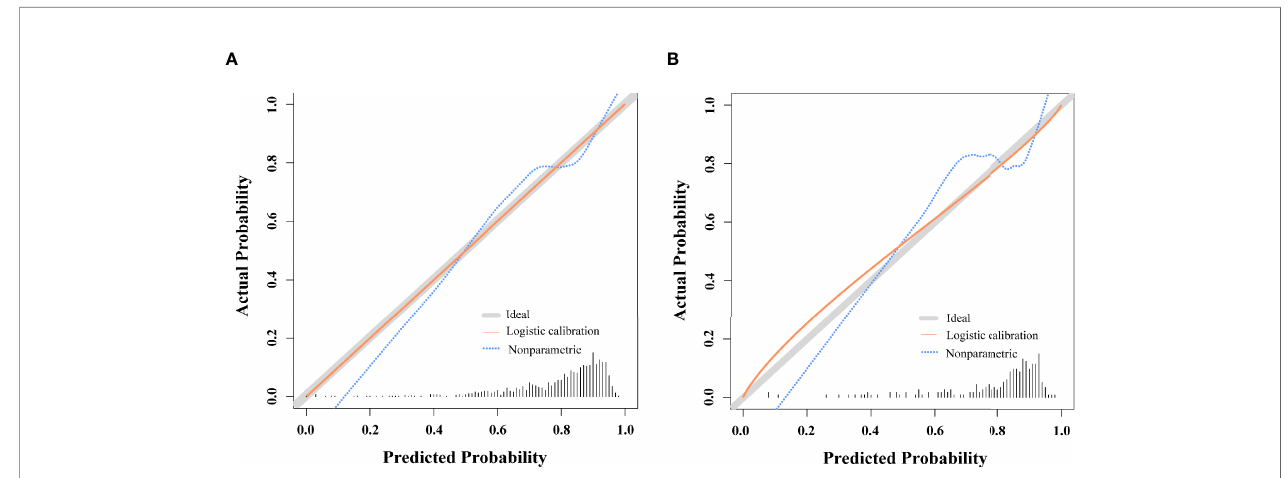
FIGURE 3 | Nomogram Calibration. (A) Calibration curves examining the relationship between the predicted odds of live birth and actual live birth rates in the training cohort. (B) Calibration curves examining the relationship between the predicted odds of live birth and actual live birth rates in the validation cohort.